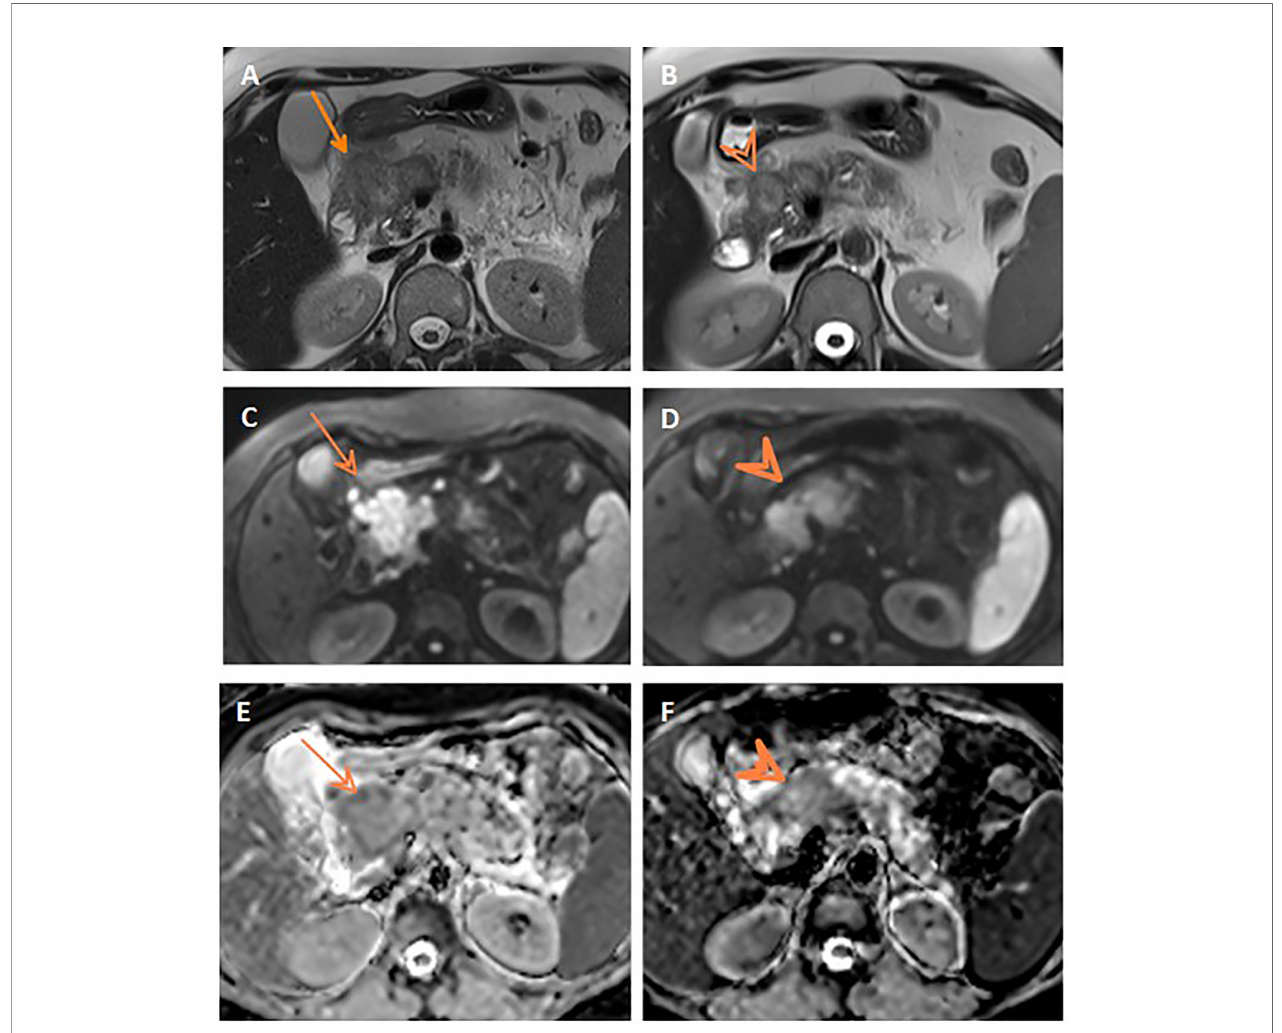
FIGURE 4 | Discordant response between ADC and RECIST. Axial T2WI (A) shows progression of the pancreatic mass after neoadjuvant therapy compared to initial axial T2WI (B) . Post-treatment and initial DWIs ( C , D, respectively) show corresponding restricted DWI of the mass. Post-treatment and initial ADC maps ( E, F, respectively) show comparable ADC values of the mass on both